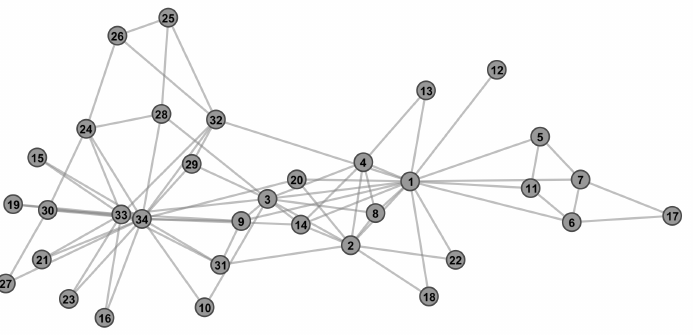
Figure 1. Zachary’s social network of friendships between 34 members of a karate club at a US university in the 1970s. An edge connects two individuals if they socialized outside of the club.